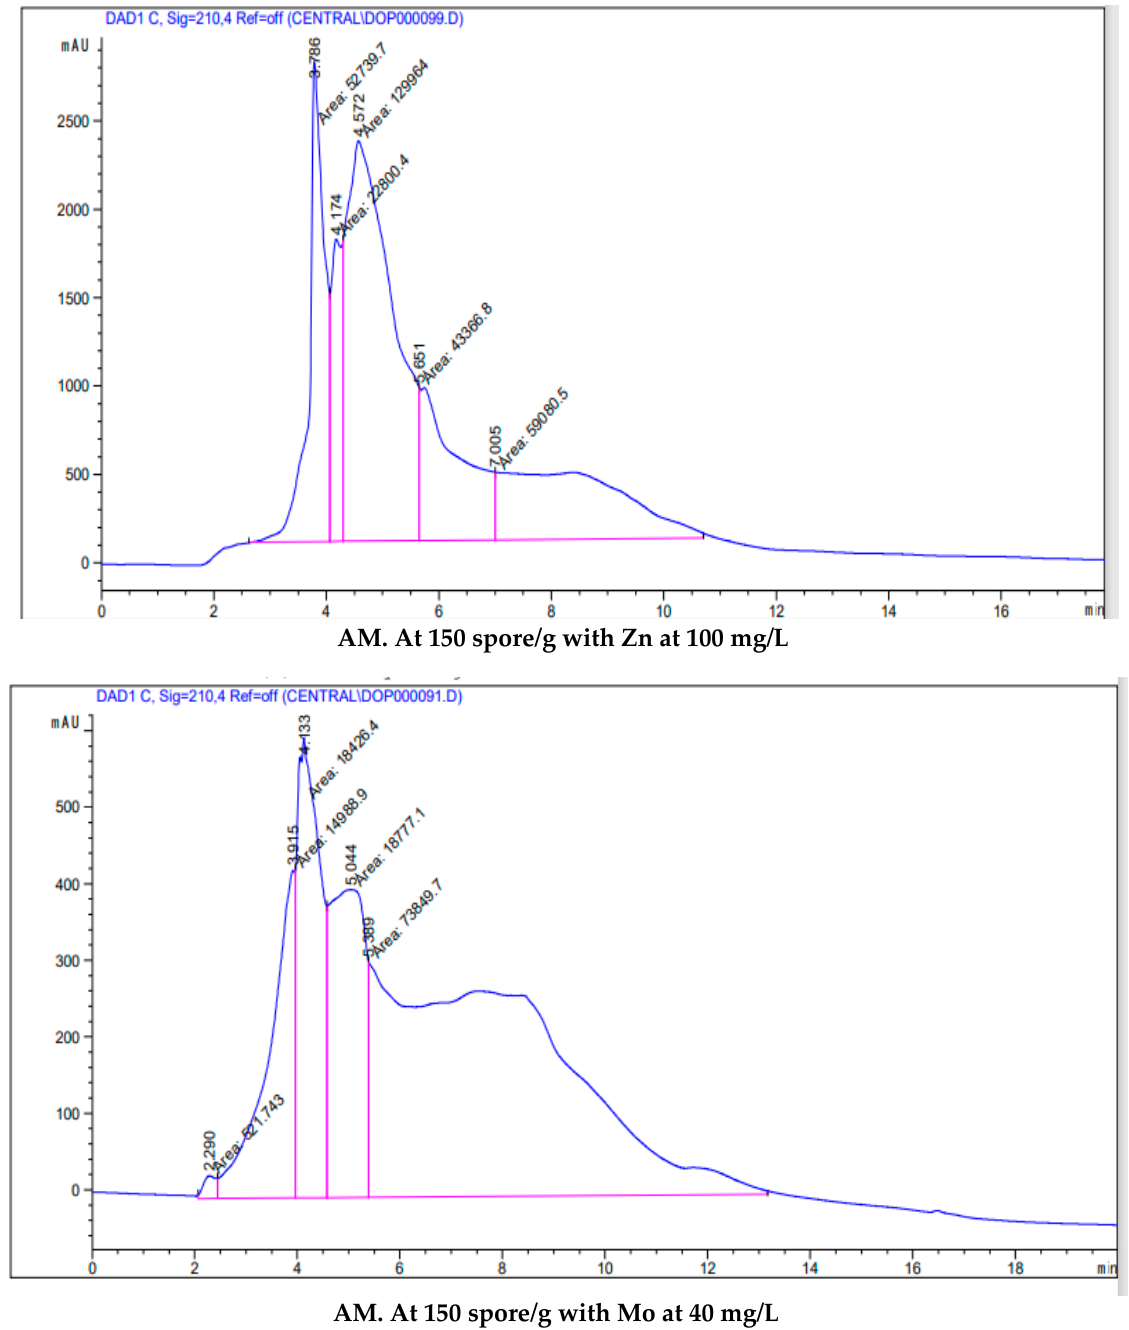
Figure 2. Effect of Arbuscular Mycorrhiza (AM) and Nano B, Zn, and Mo microelements on stevioside contents of stevia leaves during 2020 season.